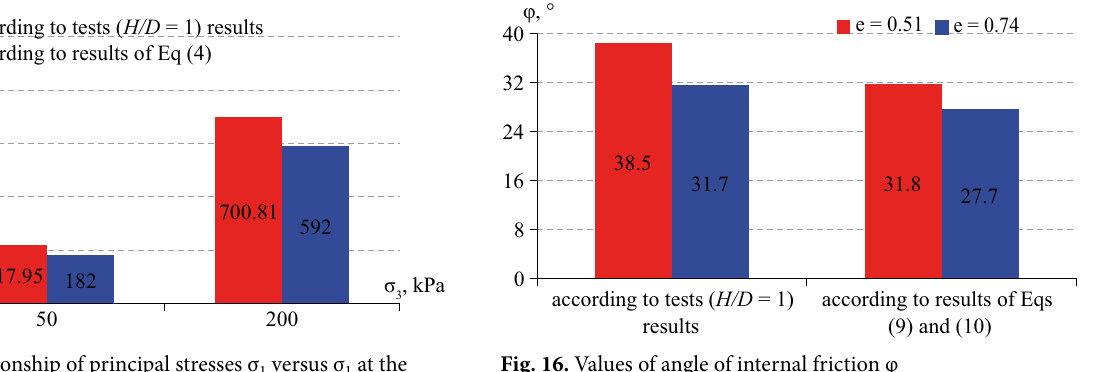
Fig. 13. Relationship of principal stresses σ 1 versus σ 1 at the critical state for loose sand ( e = 0.74)